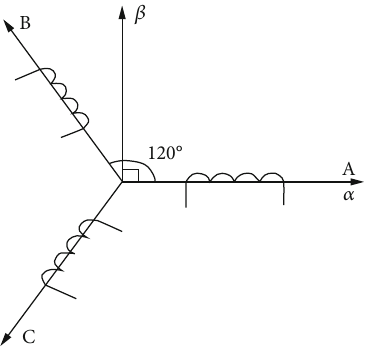
Figure 2: Stationary stator coordinate.